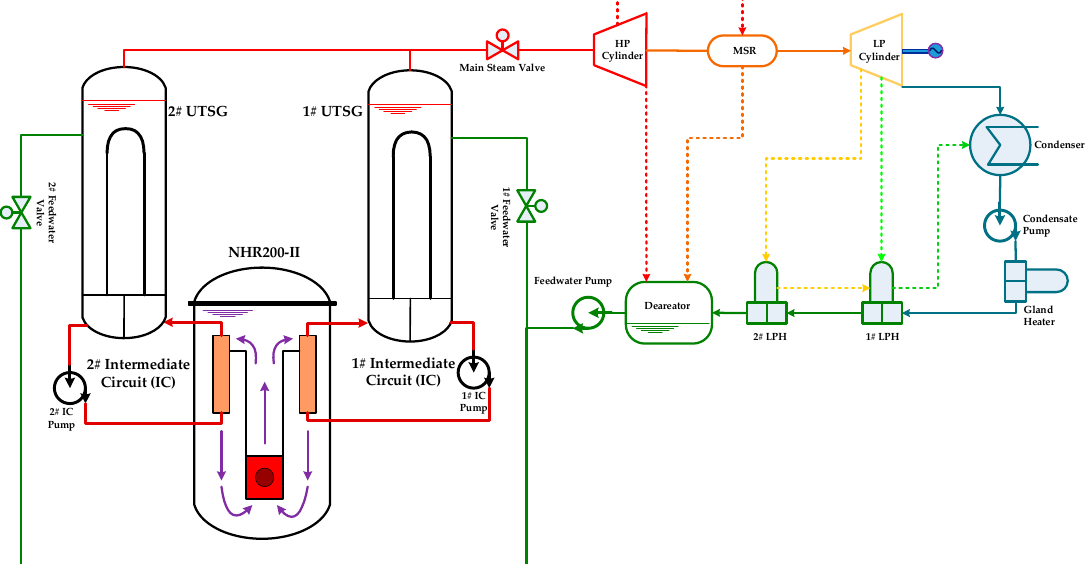
Figure 2. Shematic process diagram of the nuclear heating reactor (NHR)-based power plant.